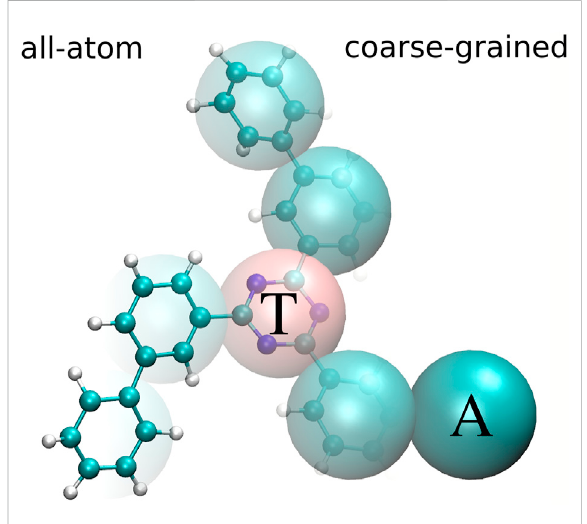
FIGURE 1 All-atom (left) and coarse-grained (right) representation of tris-meta-biphenyl-triazine. The central triazine ring is mapped to one bead of type T and all phenyl rings are mapped to beads of type